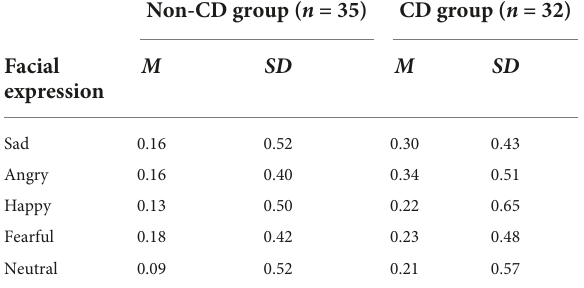
TABLE 6 The average reporting criterion (C) in delayed-match-to-sample (DMTS)